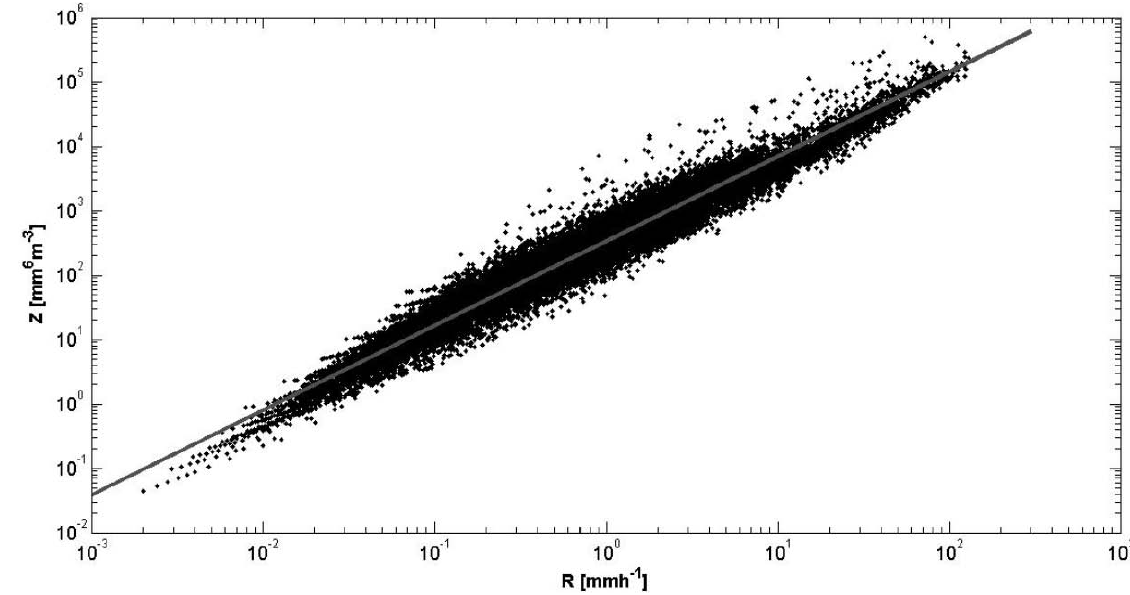
Figure 1. Radar reflectivity factor Z vs. rain rate R as deduced from the 1-min rain RDSD (Rain Drop Size Distribution) observed with the JWD (Joss-Waldvogel Disdrometer) in Dakar (Senegal), during 1997–2002, and fitted